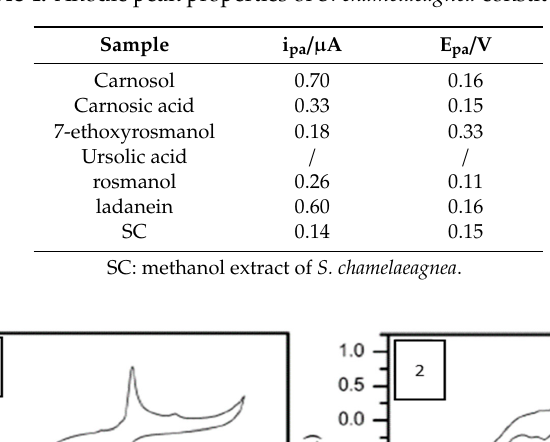
Figure 3. Cyclic voltammograms of isolated compounds. The voltammograms were recorded at 50 mV/s (from − 1300 to 1300 mV) for 1 mg/L of each compound in phosphate buffer (pH 6.5). 4. Conclusion These studies revealed that S. chamelaeagnea methanolic extract is a source of abietane diterpenes which show appreciable antioxidant activity when FRAP, TEAC, ORAC were used as test methods. The electrochemical property of all the compounds isolated and reported was also examined. The effective use of cyclic voltammetry as a reliable analytical method to characterize the reducing ability and electrochemical behavior of phenolic antioxidants in plants has been shown previously. We observed that the measured oxidation potential was closely related to the structures of the investigated compounds. The antioxidant activity of these compounds relates well to the number of OH group in structure, and compounds with two or more electron donating groups have